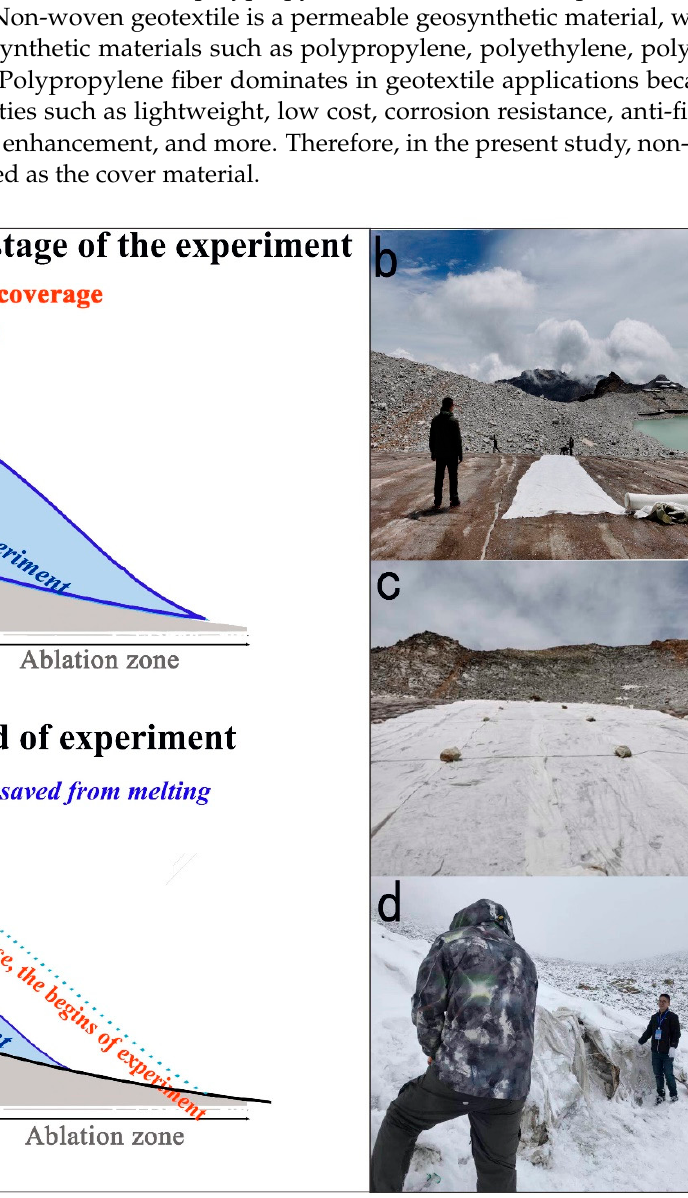
Figure 2. ( a ) Schematic diagram of the artificial cover for reducing glacier melt using non-woven geotextiles in the ablation zone (refer to [11]). ( b – d ) The overview of the study site at the beginning and the end of the experiment.